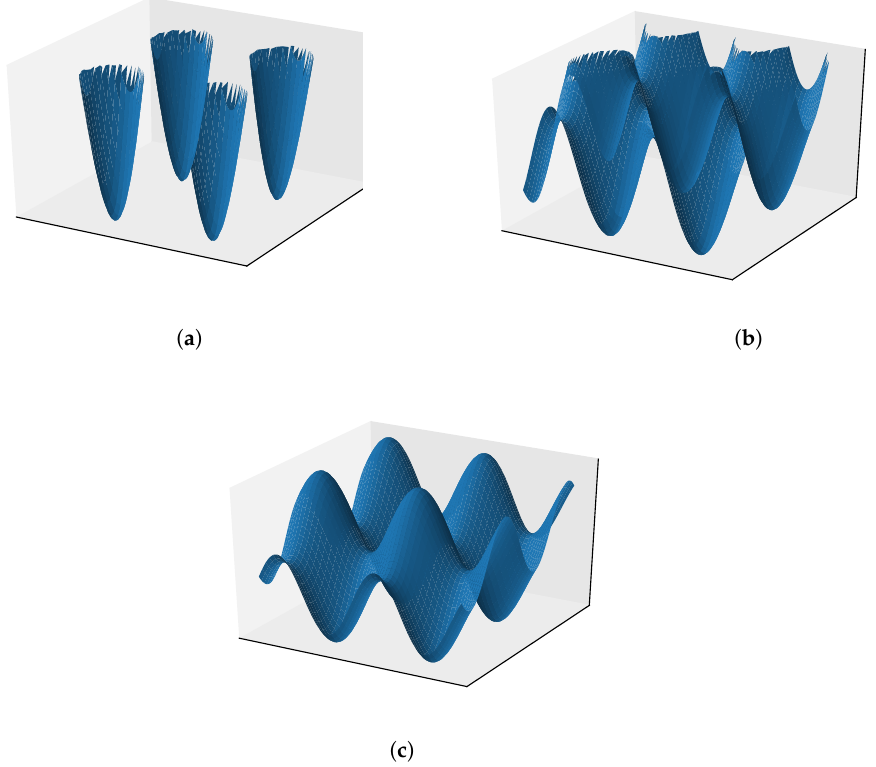
Figure 8. An example of filtration process: ( a ) k 0 ; ( b ) k 2 ; ( c ) k 19